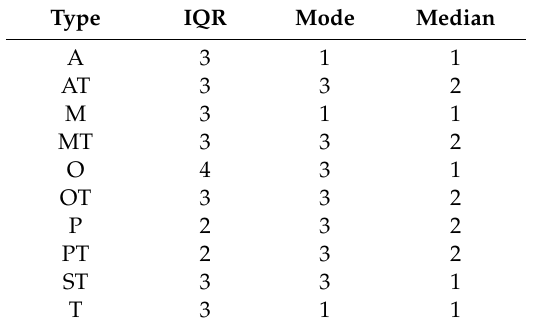
Figure 5. Histogram of all type ratings, based on a seven-grade rating scale: − 3 (bad type) - + 3 (good type). Some trends in the data can already be observed from the medians (Table 2). All types without text, except for the picture type (P), have a lower median. Additionally, symbol and text (T, ST) got lower ratings as well. The mode values show that map, text and 3D-simualtion overview (M, T, A) mostly got rated + 1, opposed to + 3 for the other types. Table 2. Descriptive statistics, based on a seven-grade rating scale: -3 (bad type) - +3 (good type).